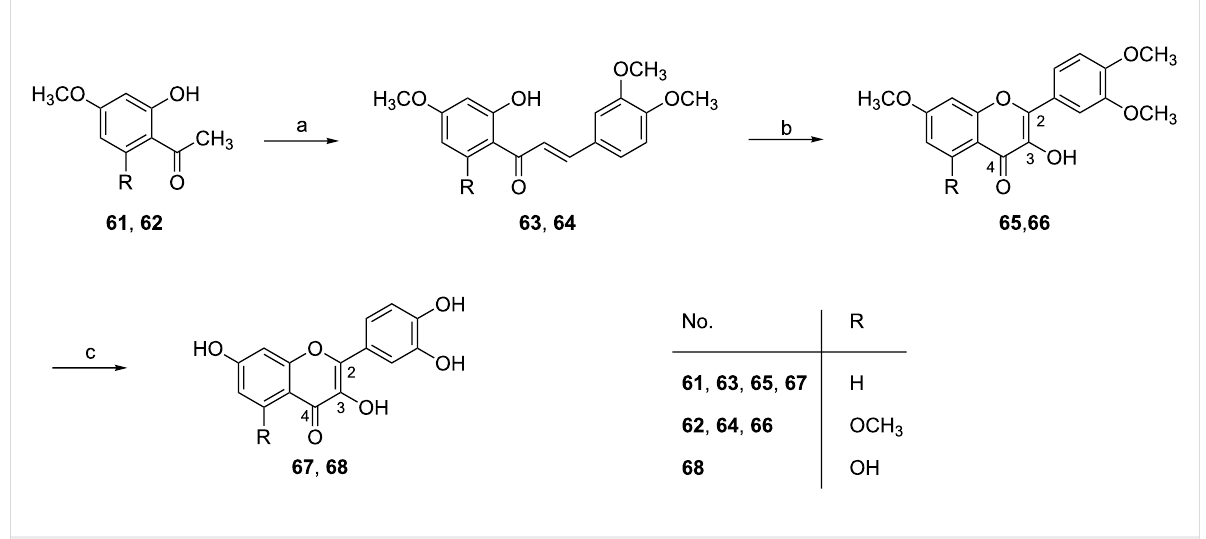
Scheme 11: Synthesis of fisetin ( 67 ) and quercetin ( 68 ). Reagents and conditions: (a) 3,4-dimethoxybenzaldehyde, KOH, DMF, 0 °C; (b) BiCO 3 , AcOH, 2-ethoxyethanol, Δ ; (c) BBr 3 , DCM, − 78 °C → rt.